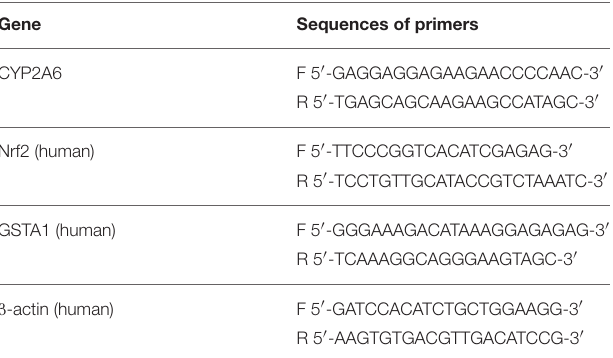
TABLE 1 | The primer sequences for Real-Time